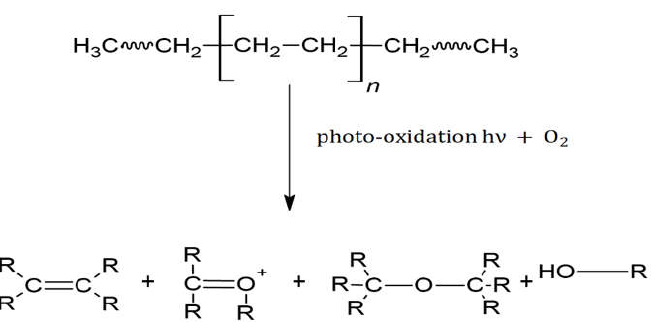
Figure 2. Polyethylene photo-oxidation degradation process (with the carbonyl groups formation).